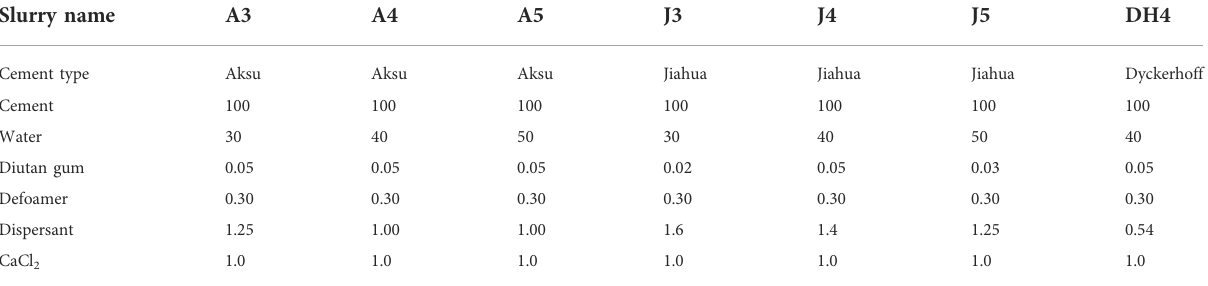
TABLE 2 Slurry composition